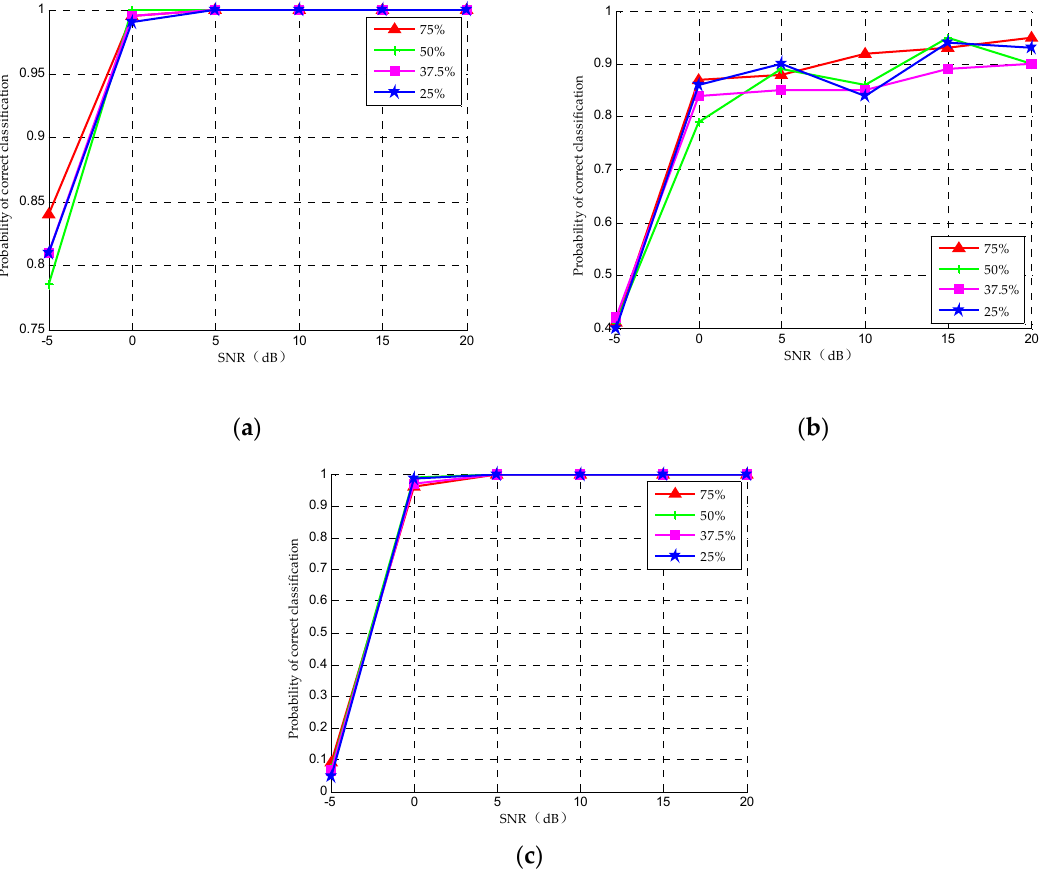
Figure 6. Correct classification rate with different compression rate for ( a ) OOK, ( b ) QPSK and ( c ) 16QAM under different SNRs.